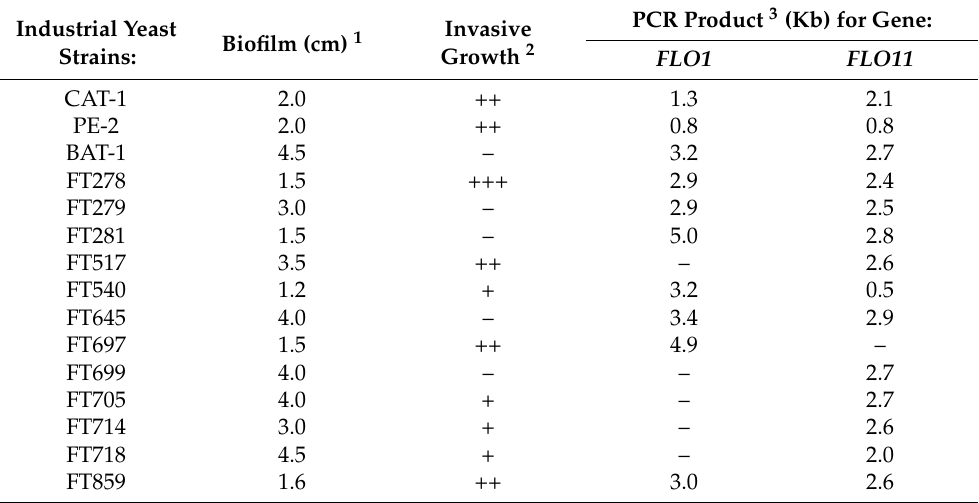
Figure 7. Deletion of FLO8 prevents foam production by the industrial fuel-ethanol strain FT859.